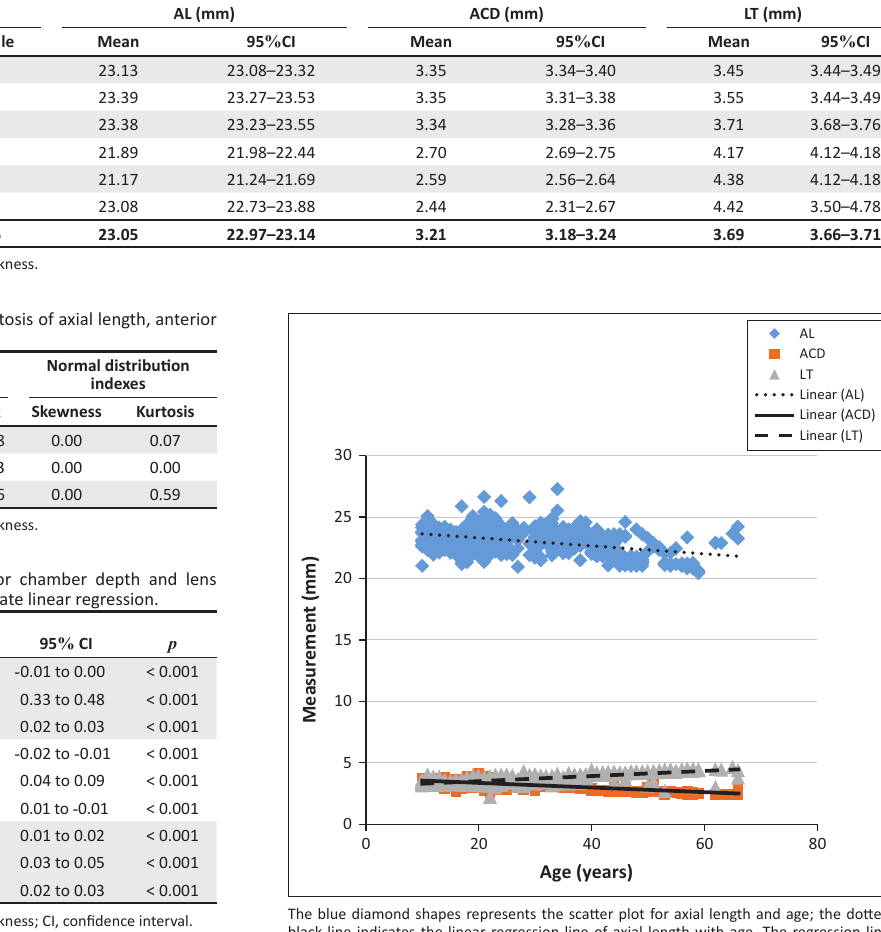
TABLE 4: The association of axial length, anterior chamber depth and lens thickness with age and gender in multivariate linear regression. Ocular biometry variable Associated factor